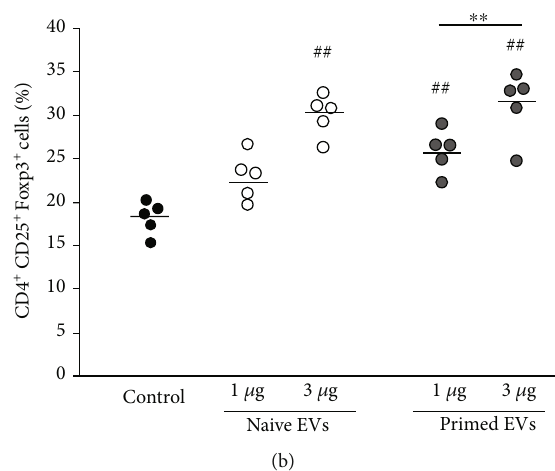
Figure 10: Treg cells after coculture of PBMCs with cADSC-EVs. (a) Flow cytometric detection of CD3 + CD4 + CD25 + Foxp3 + cells (gated in red square). Control: PBMCs cultured without cADSC-EVs. (b) Comparison of the population of CD3 + CD4 + CD25 + Foxp3 + cells after coculture of PBMCs with various concentrations (1 or 3 μ g/ml) of naive or primed cADSC-EVs. The ratio of Treg cells was not signi fi cantly di ff erent between naive and primed EVs at the same concentrations. The solid line indicates the average. ## P < 0 : 01 vs. control. ∗∗ P < 0 : 01 , between concentrations of 1 and 3 μ